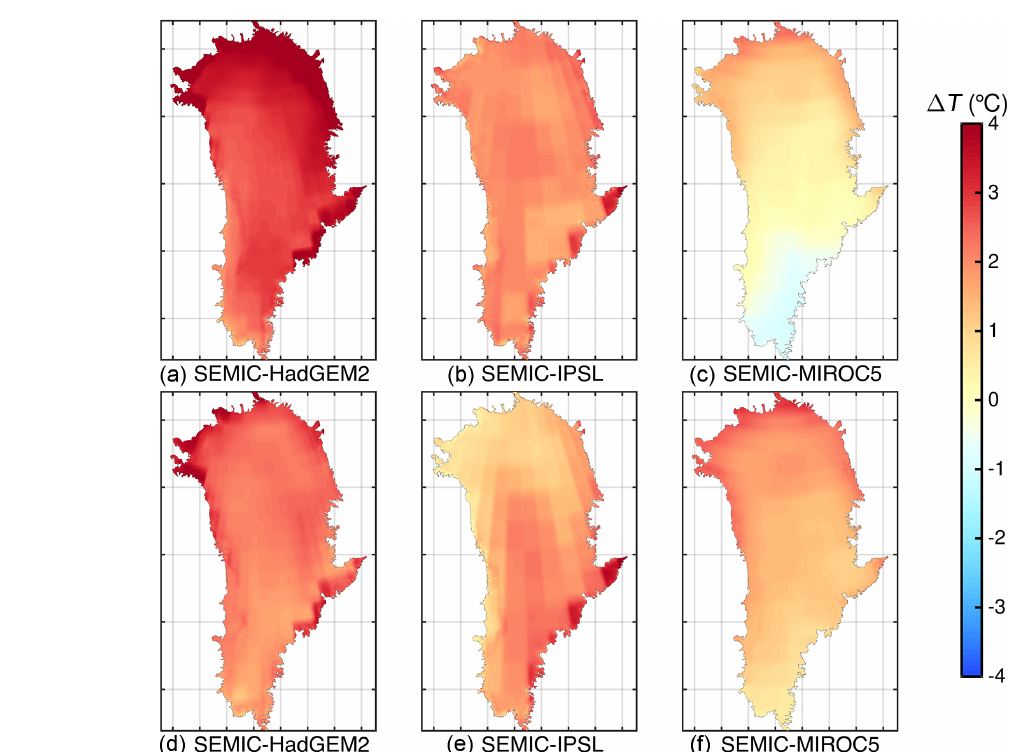
Figure 7. Comparison of multi-year mean surface temperature ( T s ) differences between 2100–2000 (a–c) and 2300–2000 (d–f) for (a, d) SEMIC-HadGEM2, (b, e) SEMIC-IPSL, and (c, f) SEMIC-MIROC5. The black contour line depicts the present-day ice